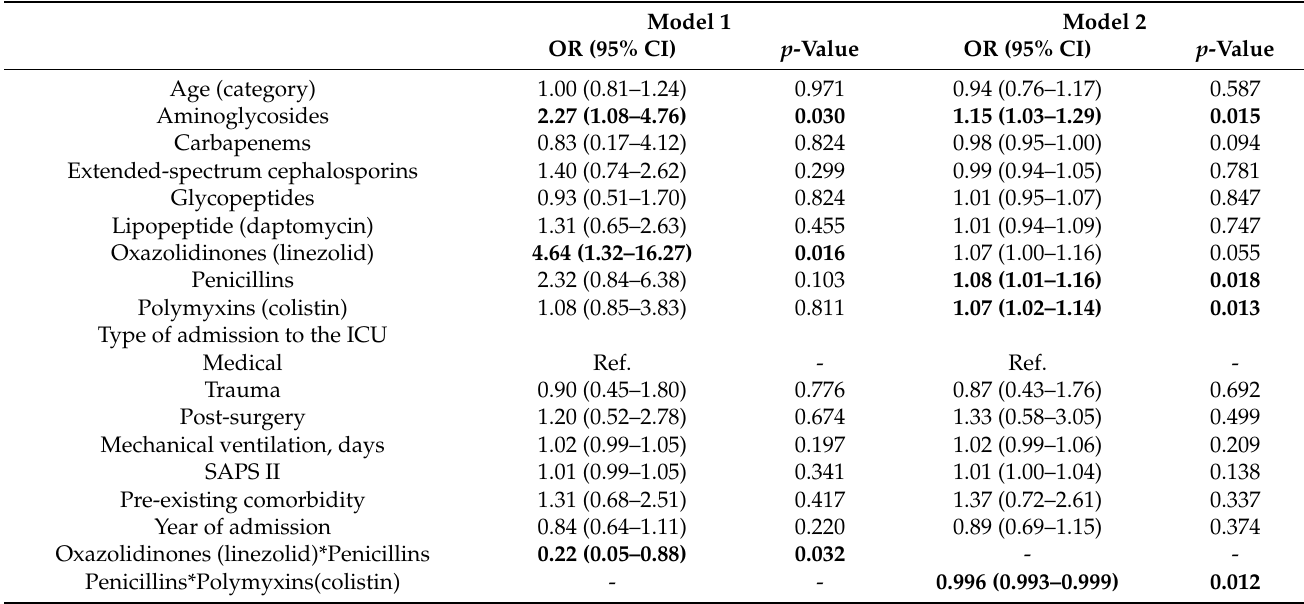
Table 4. Multivariable conditional logistic regression models for developing healthcare-associated infections sustained by multidrug-resistant Klebsiella pneumoniae (Model 1: prior exposure to an antibiotic class is coded as dichotomous (yes vs. no); Model 2: prior exposure to an antibiotic class is coded as continuous (days of cumulative